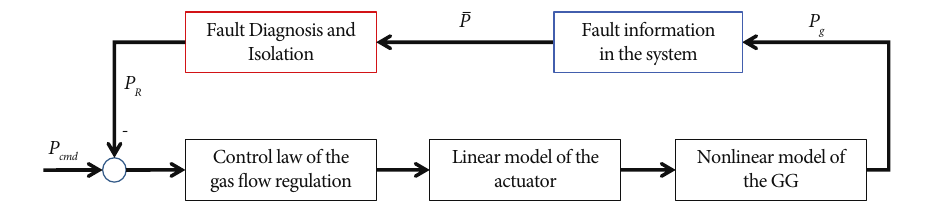
Figure 9: Control schematic with fault diagnosis and isolation algorithms.